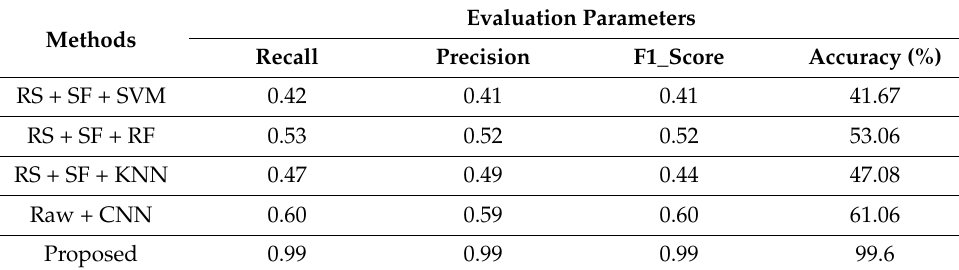
Table 6. The results of the evaluation parameters of five different approaches.